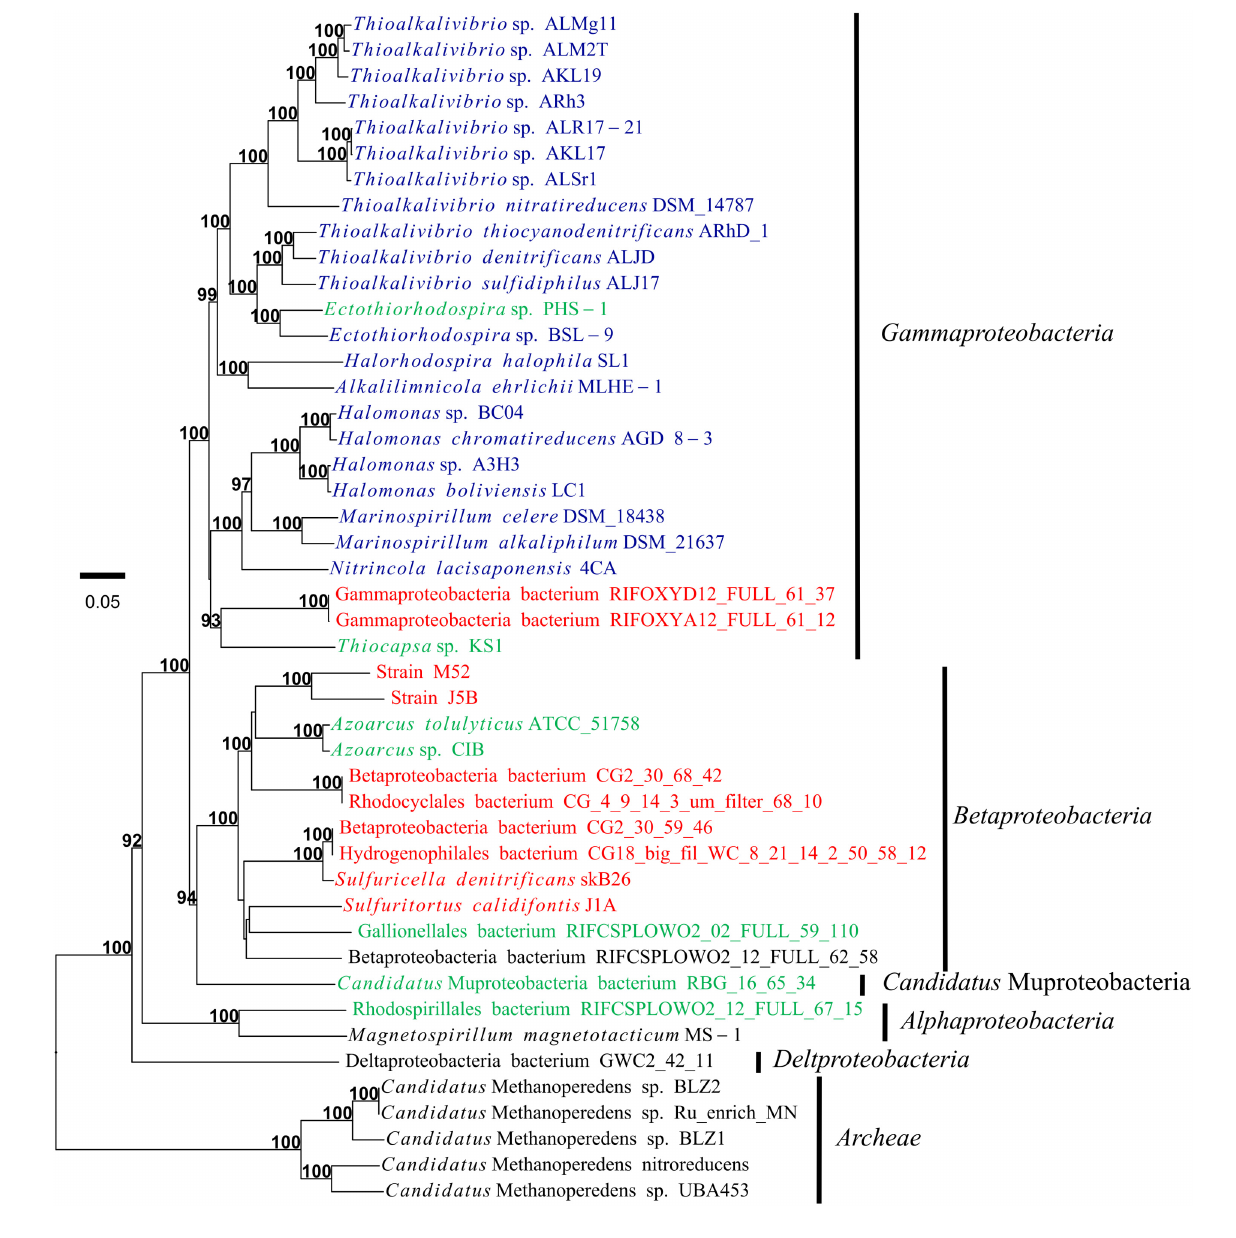
FIGURE 7 | Phylogeny of the organisms possessing the arx genes, based on the concatenated amino acid sequences of 10 ribosomal proteins. Support values greater than 70% are indicated in bold. Rhodocyclaceae bacterium UBA4043 is not included due to absence of the majority of genes encoding ribosomal proteins. Name of organisms with ARX of group 1, group 2, and group 3 are shown in blue, green and red